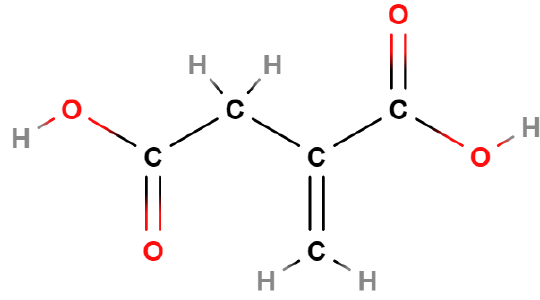
Figure 7. Structure of itaconic acid (C 5 H 6 O 4 ).